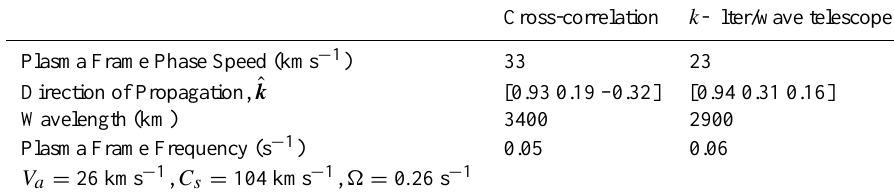
Fig. 4. Results of the k -filtering/wave telescope analysis for the interval 04:02:3 0UT–04:10:00 UT, at a fre- quency of 0.11 Hz. The plot is shown in the k z = 3 × 10 − 4 km − 1 plane. The peak in the power is seen at the appro- priate location in k x and k y . Cross-correlation k -filter/wave